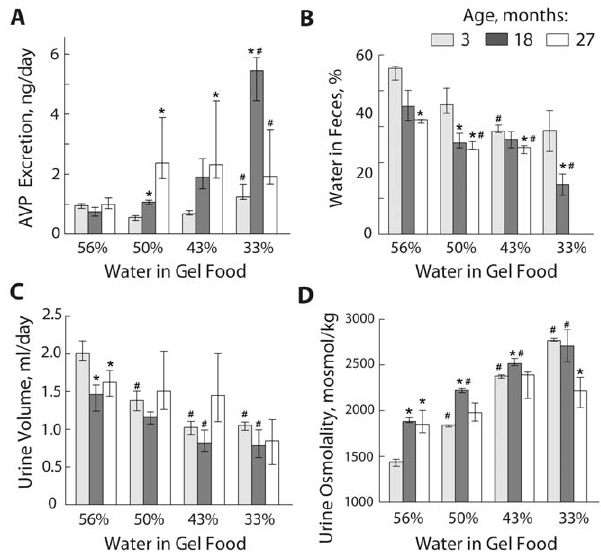
Figure 3. Analysis of activation of water conservation mecha- nisms at different levels of water consumption. A) AVP excretion; B) % of water in feces; Note: data are missing for 27 month old mice when gel food contained 33% of water because the mice became constipated; C) Urine volume; D) Urine Osmolality. Data are presented as median and IQR, n=3–4, * P , 0.05 relative to 3 months old; # P , 0.05 relative to 56% water in gel food; Mann-Whitney Test (one-tailed).